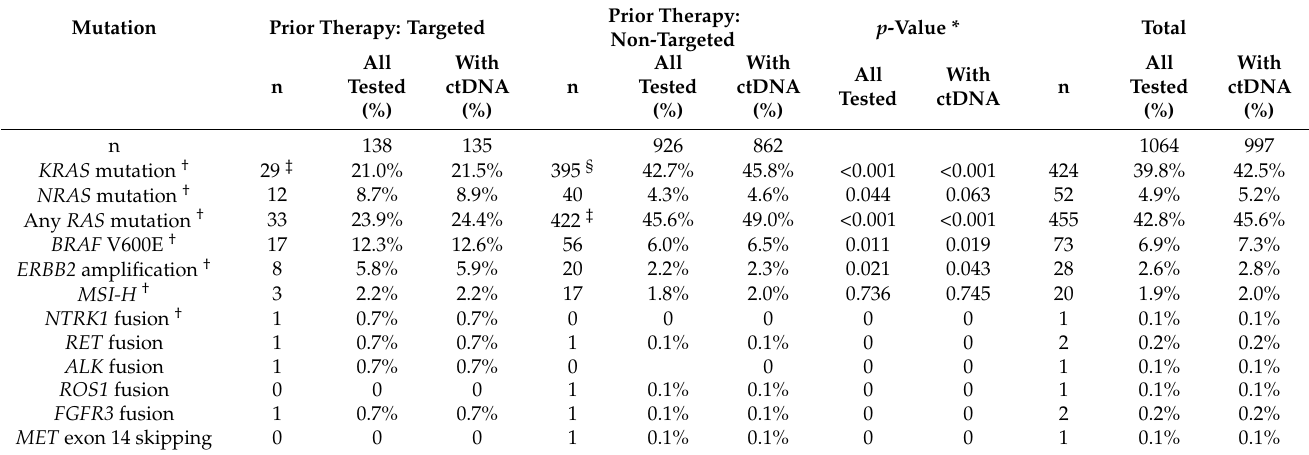
Table 2. Frequencies of clinically informative alterations detected by ctDNA.